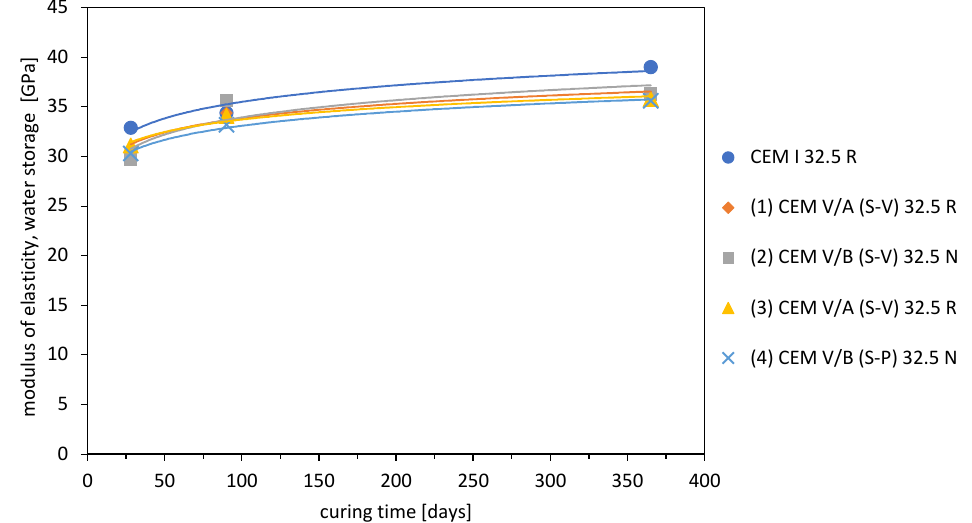
Figure 9. Modulus of elasticity (static) using different cement types at 2, 28, and 90 days of water curing (each value as mean value of 3 individual tests).